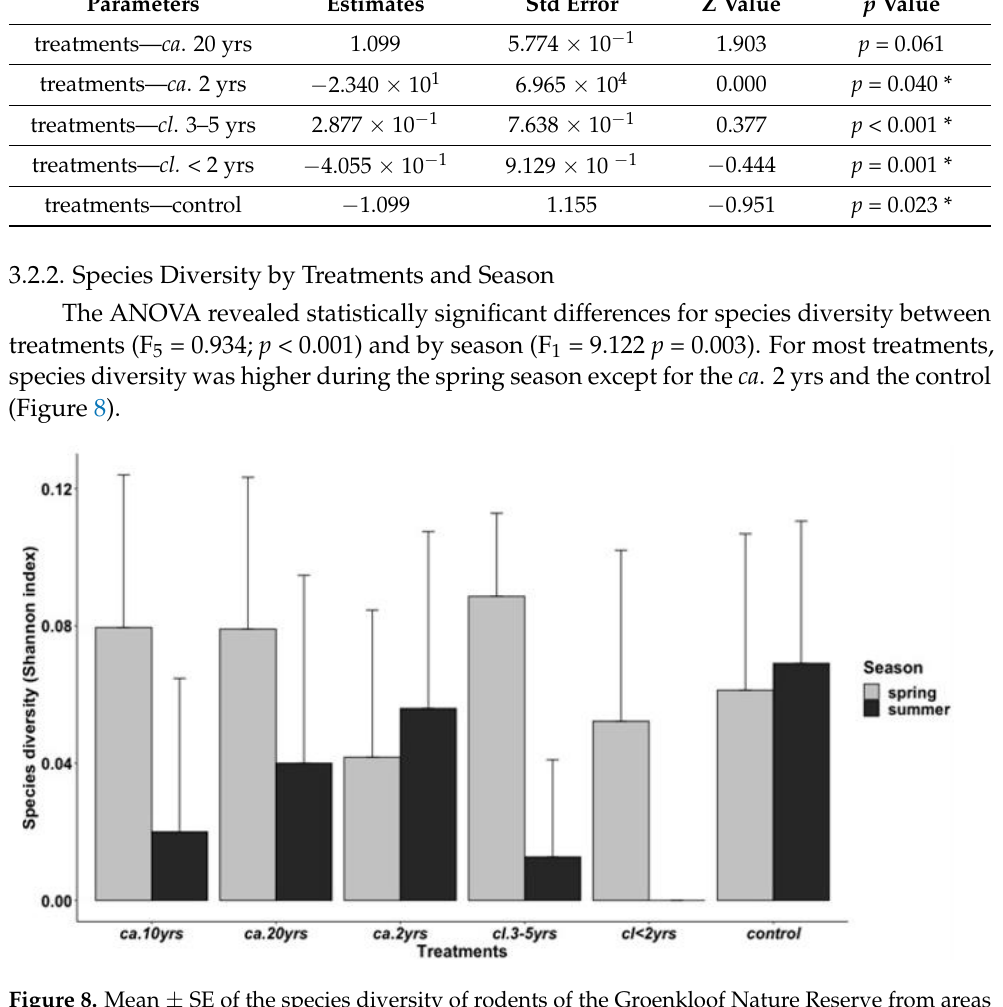
Figure 9. The median weight of rodents by treatments, season, and species inside the Groenkloof Nature Reserve. ( Lantana camara invasion durations ( ca ), differing Lantana camara clearing ( cl ) times, and a control area without Lantana camara invasion inside the Groenkloof Nature Reserve, South Africa). Dots outside the boxes represent outliers